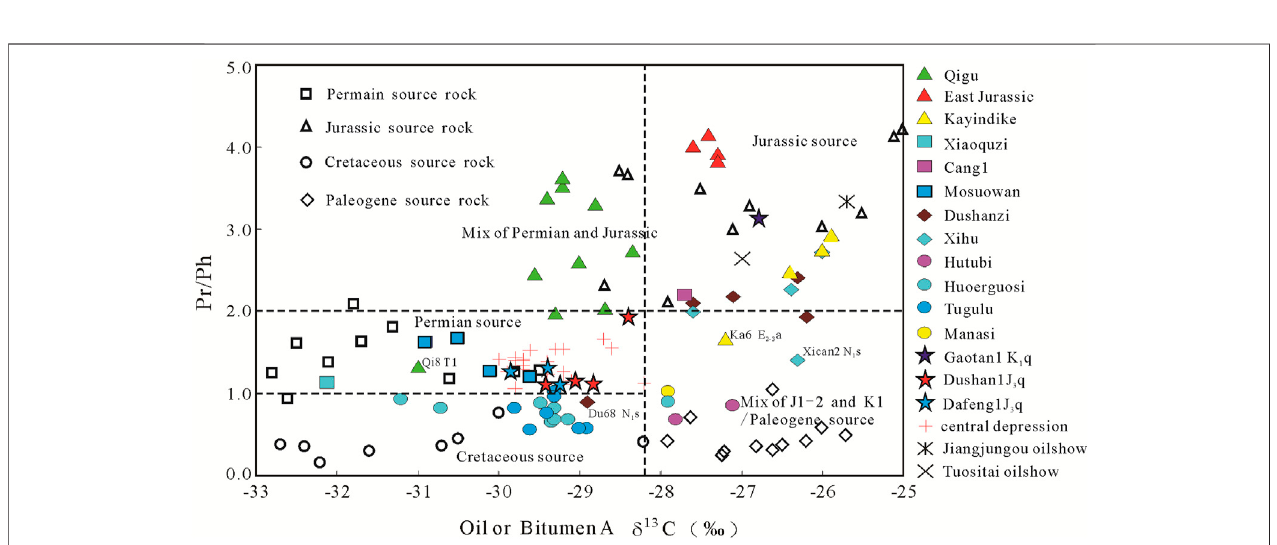
FIGURE 5 | Oil source discrimination diagram based on stable carbon isotope data and Pr/Ph values.